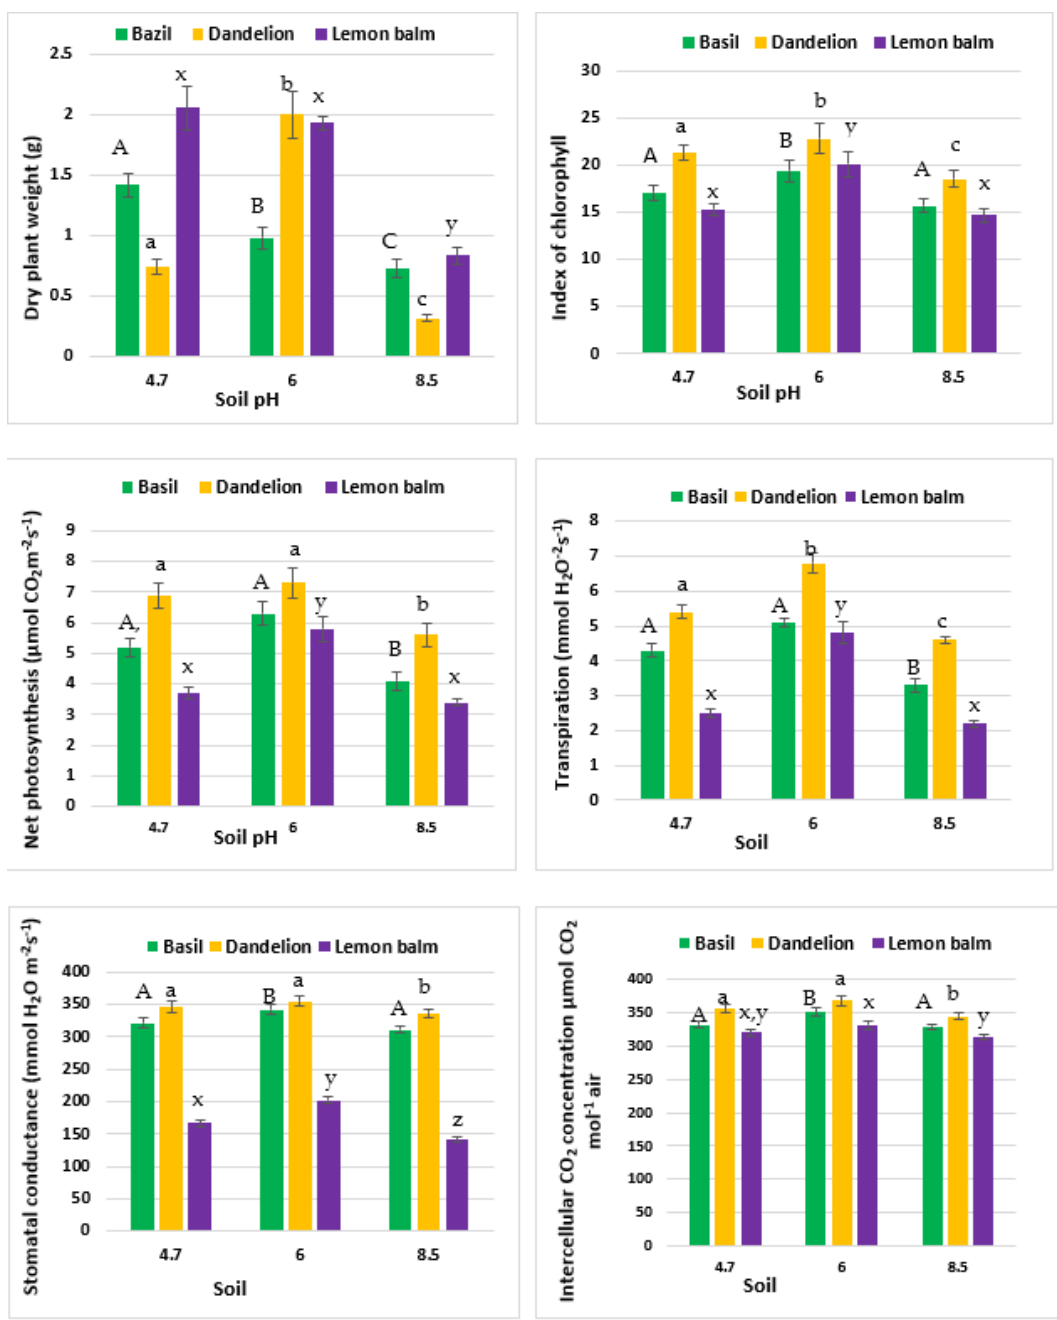
Figure 1. The effect of soil pH on the height of plants, index of chlorophyll, net photosynthesis, stomatal conductance, transpiration rate and intercellular concentration of CO 2 . Specific letters illustrate the statistically significant differences as computed with the Tukey’s HSD test ( p = 0.95) .